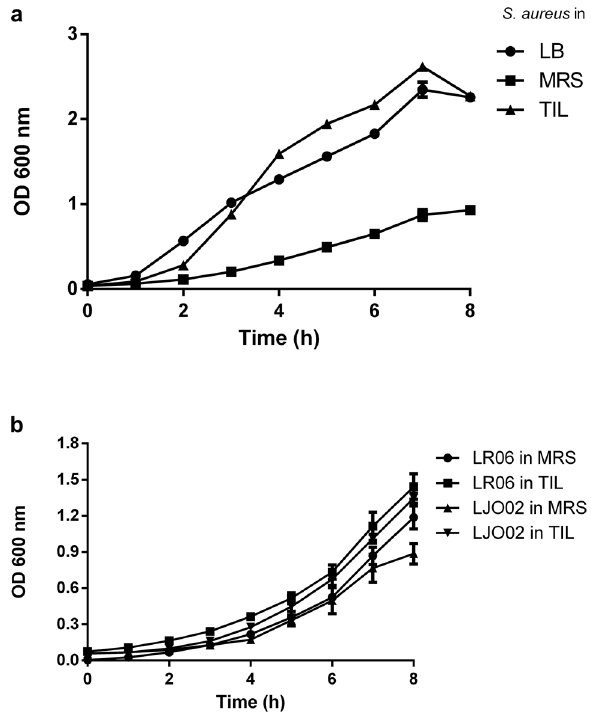
Figure 1. Bacterial strain growth curves . ( a ) S. aureus growth curves in LB, MRS, and TIL. ( b ) LR06 and LJO02 growth curves in MRS and TIL. Data are expressed as mean ± SD. All the experiments (n = 3) were repeated 3 times on different days. OD = optical